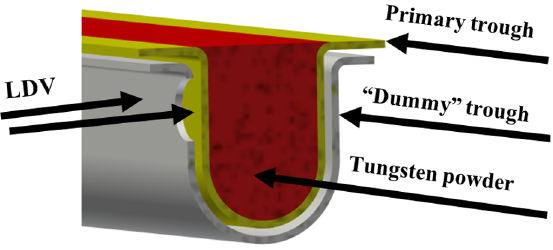
FIG. 4. Section view of the powder trough.